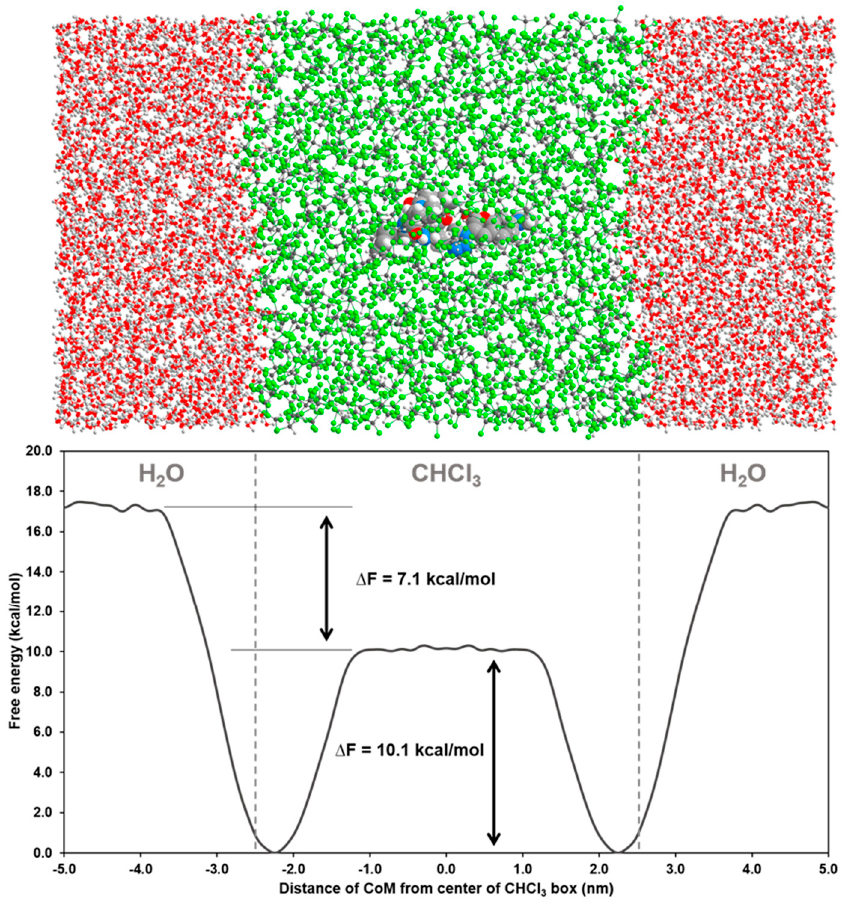
Figure 11. Free energy profiles of the compound 5 for its transit between water (red) and CHCl 3 (green).